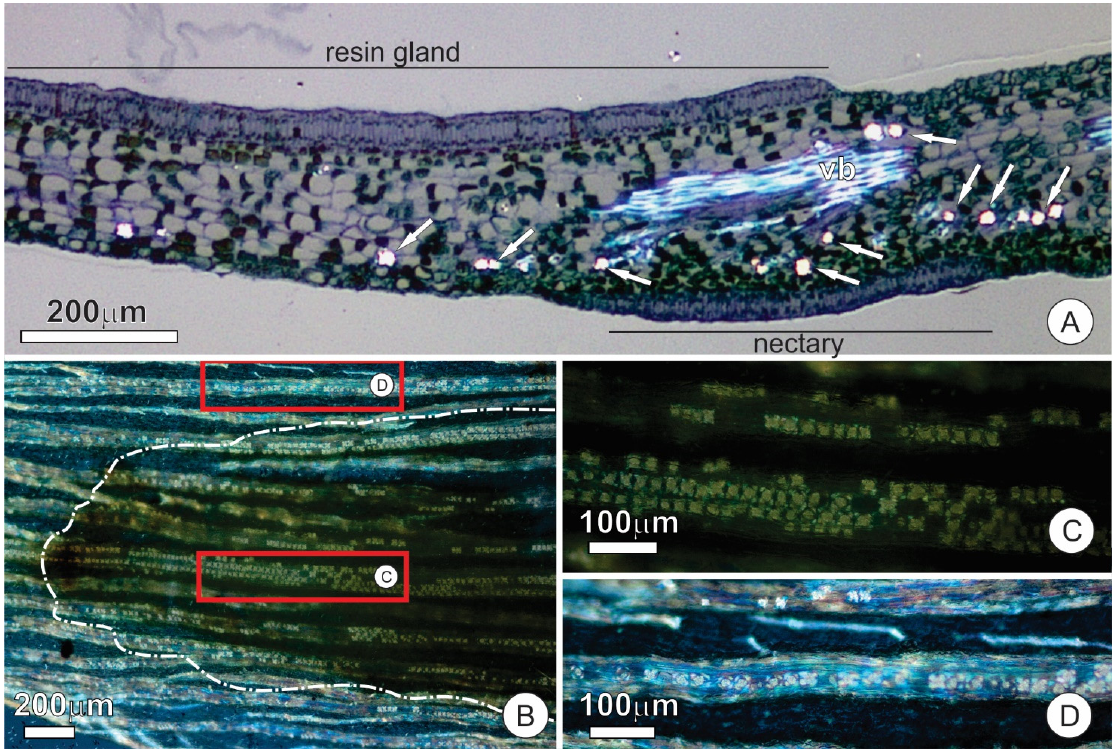
Figure 7. Distribution of calcium oxalate (CaOx) crystals in stipules of O. castaneifolia ; all images were taken under polarized light: ( A ) Longitudinal section of a stipule showing greater accumulation of crystals (arrows) towards the abaxial surface and the nectary portion. Note that crystals are absent under the resin gland (adaxial face); ( B – D ) Surface view of the nectary portion (dashed line in B) showing the distribution of crystals. Note the numerous crystals in the nectary ( C ) in comparison to the area outside the nectary ( D ); The rectangles in B indicate the detailed areas in C and D. vb = vascular bundle.